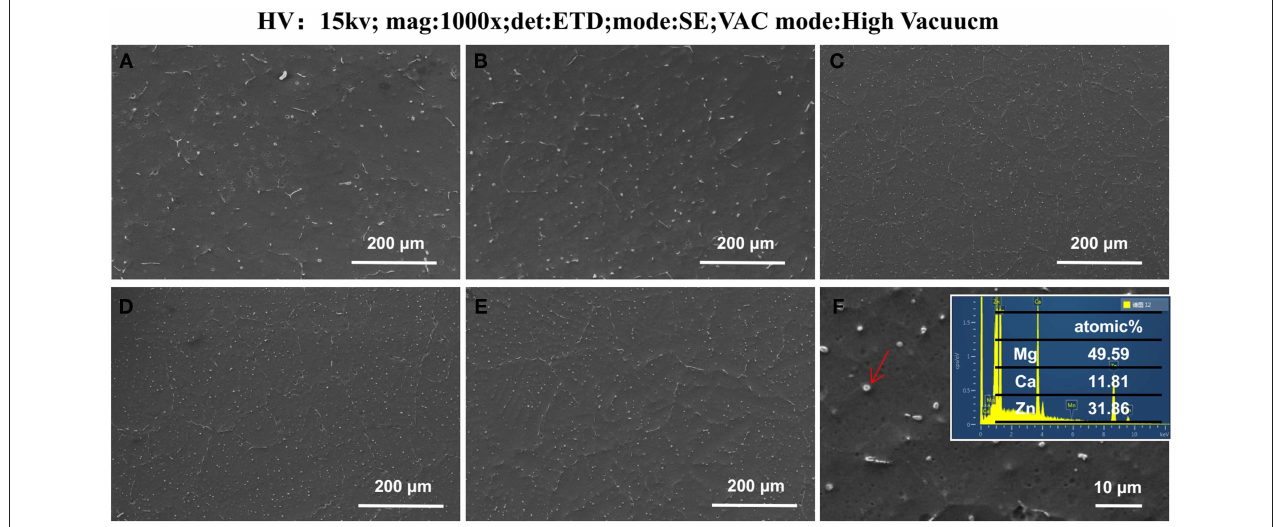
FIGURE 4 | The field-emission scanning images of as-cast homogenization MZC (A) , MZC0.3Mn (B) , MZC0.5 Mn (C) , MZC0.7Mn (D) , and MZC0.9Mn (E) alloys and the EDS image of ellipsoidal second phase (F) .